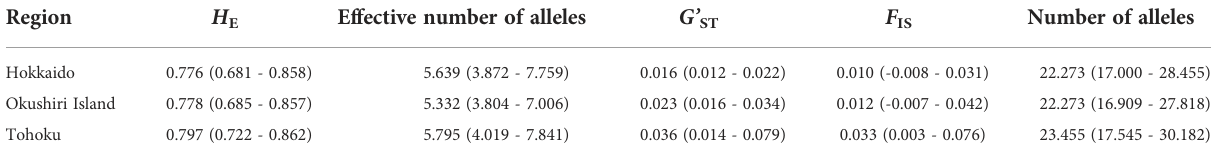
TABLE 1 Genetic parameters for each